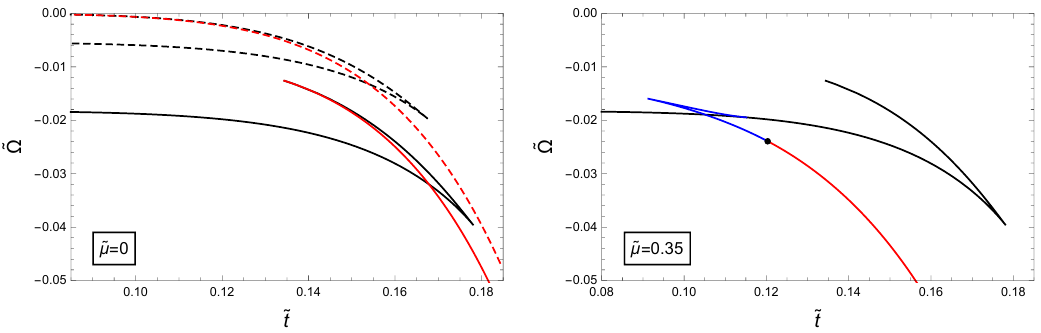
Figure 2 . Free energy as a function of temperature at two di(cid:11)erent quark chemical potentials. Solid lines in both panels correspond to a nonzero quark mass, ~ (cid:11) = 0 : 01, while the dashed curves in the left panel are obtained in the chiral limit ~ (cid:11) = 0. Black, blue, and red curves correspond to mesonic, LTQ, and HTQ phases, respectively. This color coding is also used in (cid:12)gures 3 and 4. The curve for the mesonic phase in the massive case (right panel) ends at the point where the tip of the connected (cid:13)avor branes touches the horizon, u c = u T . Here and throughout (cid:12)gures 3{6, ~ (cid:21) =